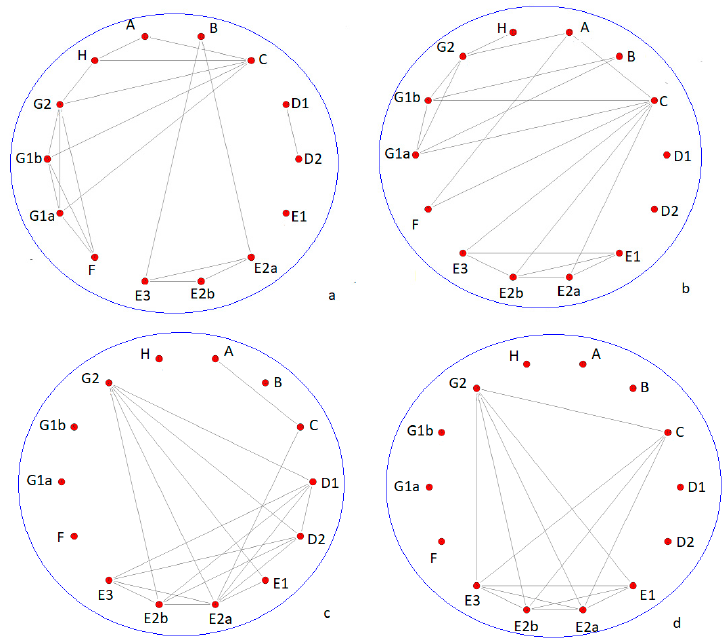
Figure 3. Network models of the co-occurrences of concepts and sub-concepts per age group: 20–30